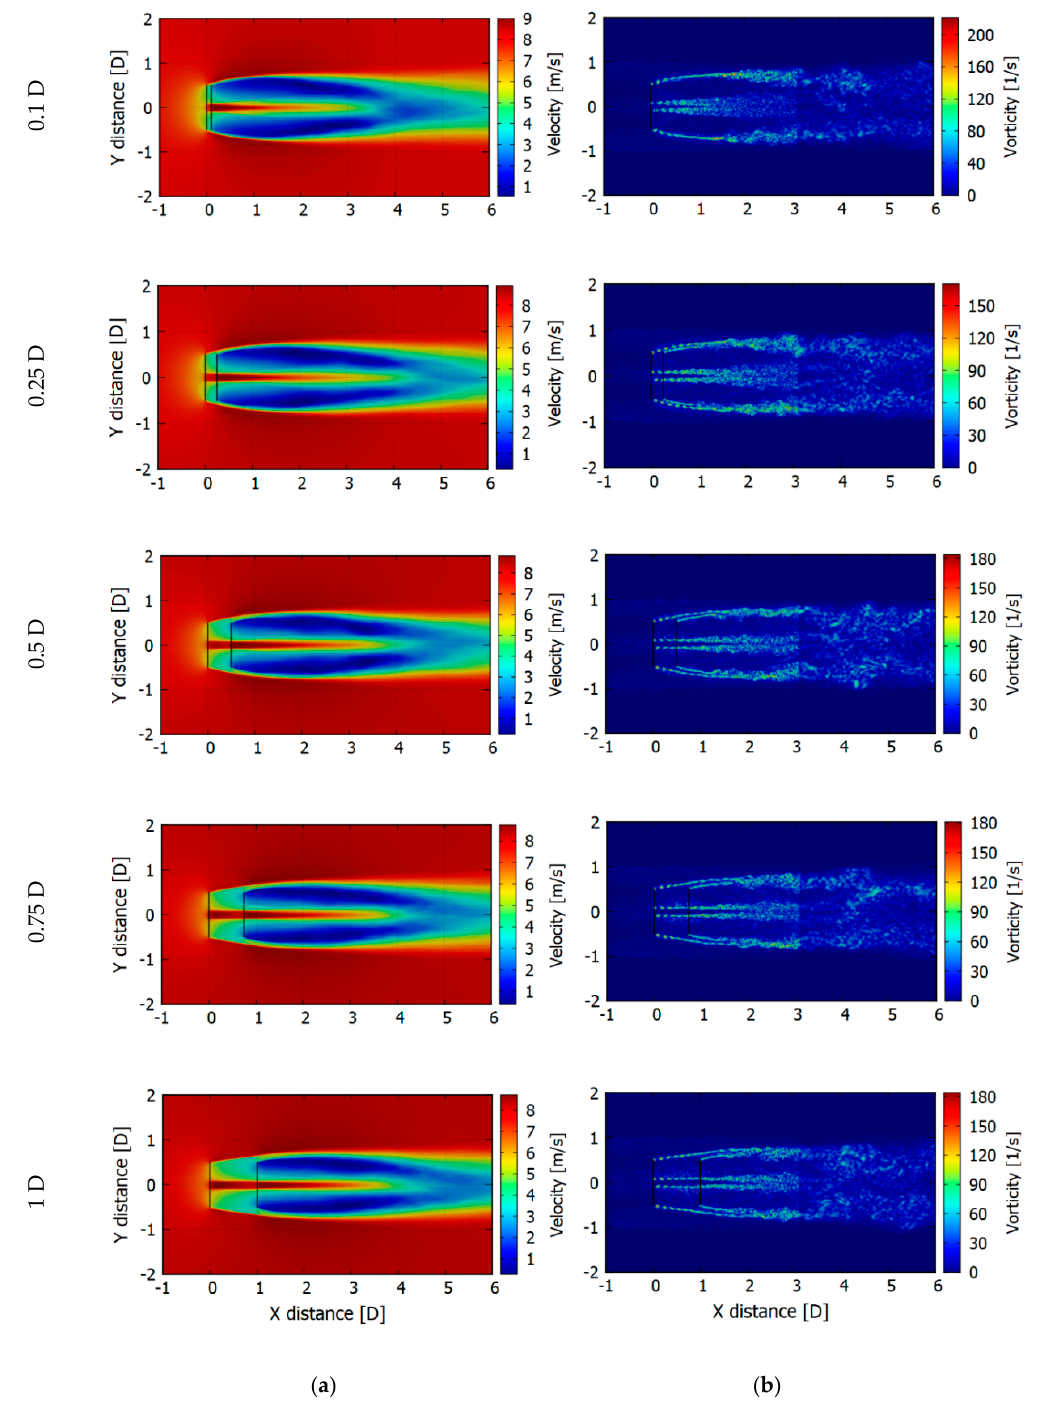
Figure 13. Mean velocity ( a ) and vortices ( b ) contours for CRWT operating with TSR 1 = TSR 2 = 5.